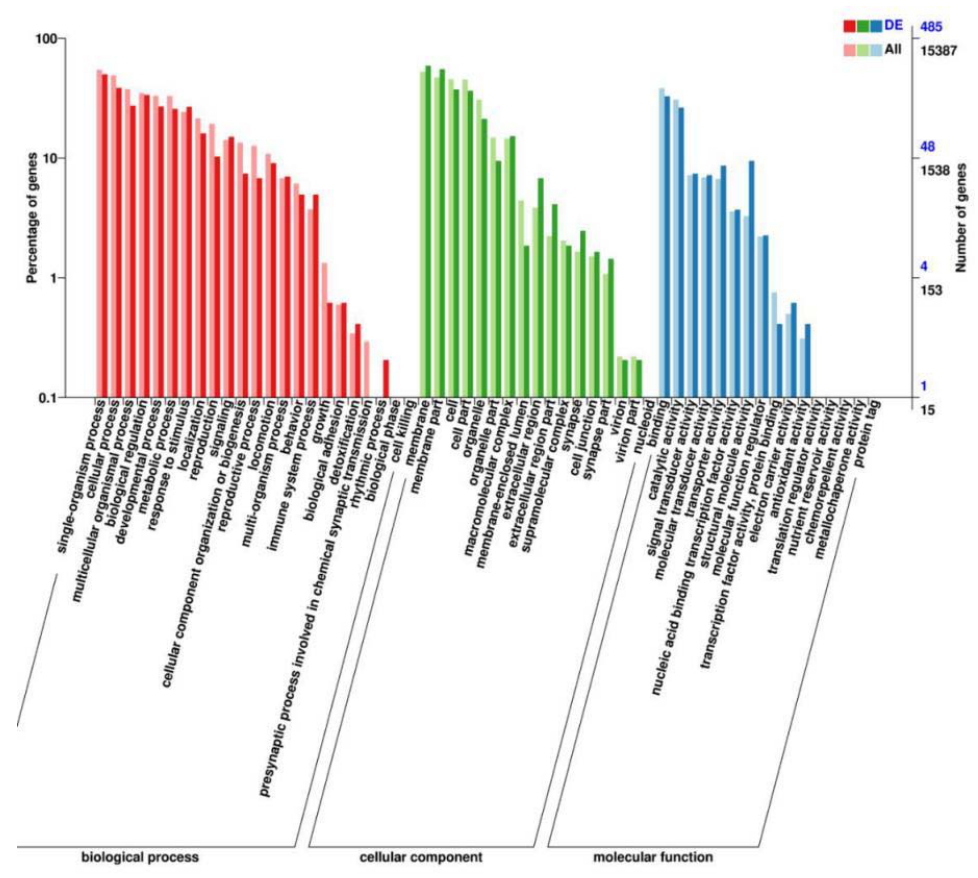
Figure 6. GO analysis of the genes significantly regulated in TG-treated C. elegans .